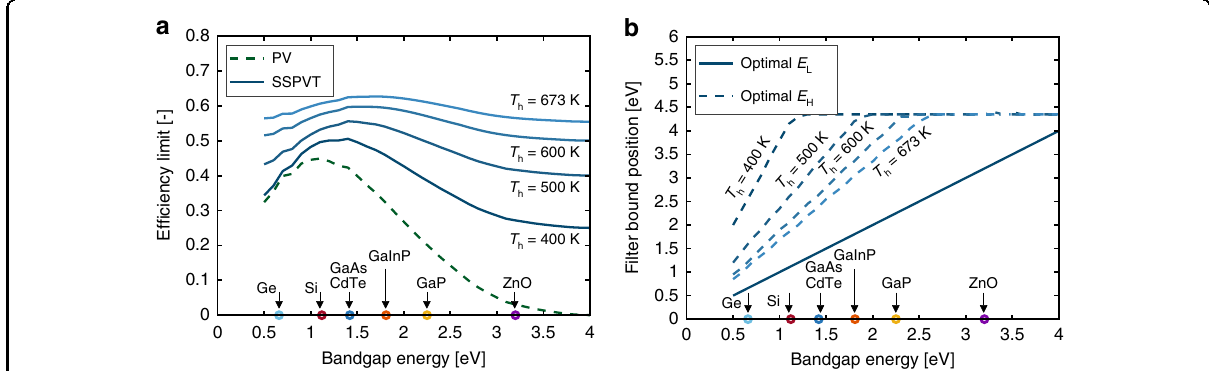
Fig. 6 a Total effective ef fi ciency limits and b optimal lower and upper bounds of spectral-splitting fi lters for SSPVT power-generation applications ( w = 1 − T h / T c , C = 45,000). Output temperatures T h = 400, 500, 600 and 673 K correspond to w = 0.25, 0.40, 0.50 and 0.55,